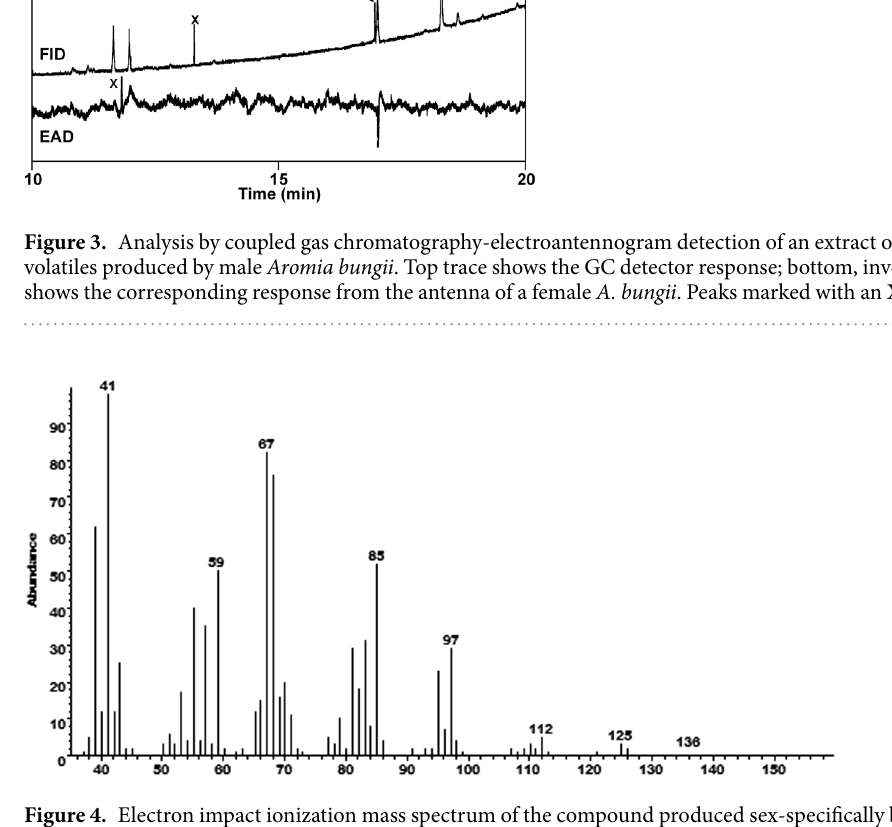
Figure 4. Electron impact ionization mass spectrum of the compound produced sex-specifically by male Aromia bungii that elicited responses from antennae of